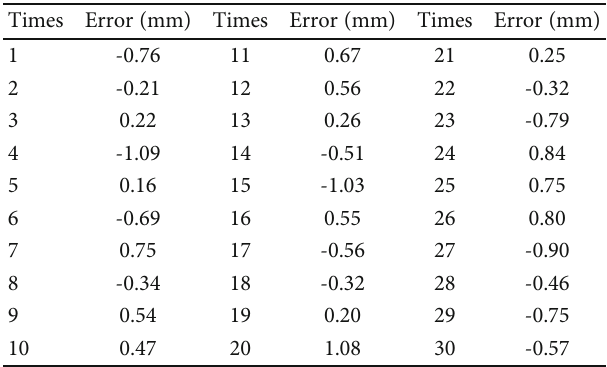
Table 3: Positioning error of hydraulic rod with 80mm movement